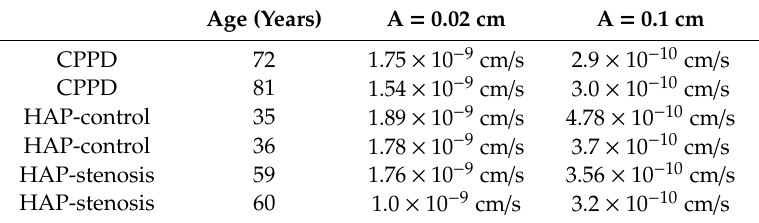
Table 2. da / dt for the minimum and maximum radius ( a ) of CPPD and HAP grains for selected cases of